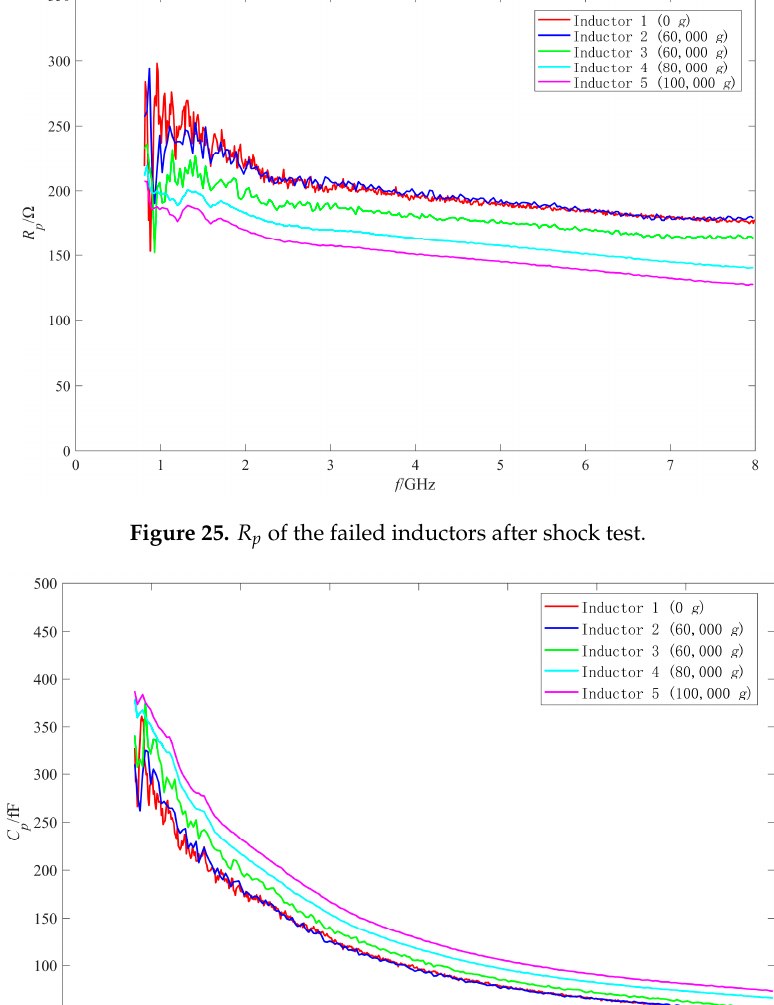
Figure 24. The imaginary part of 𝑌 (cid:3046) of the failed inductors after shock test.